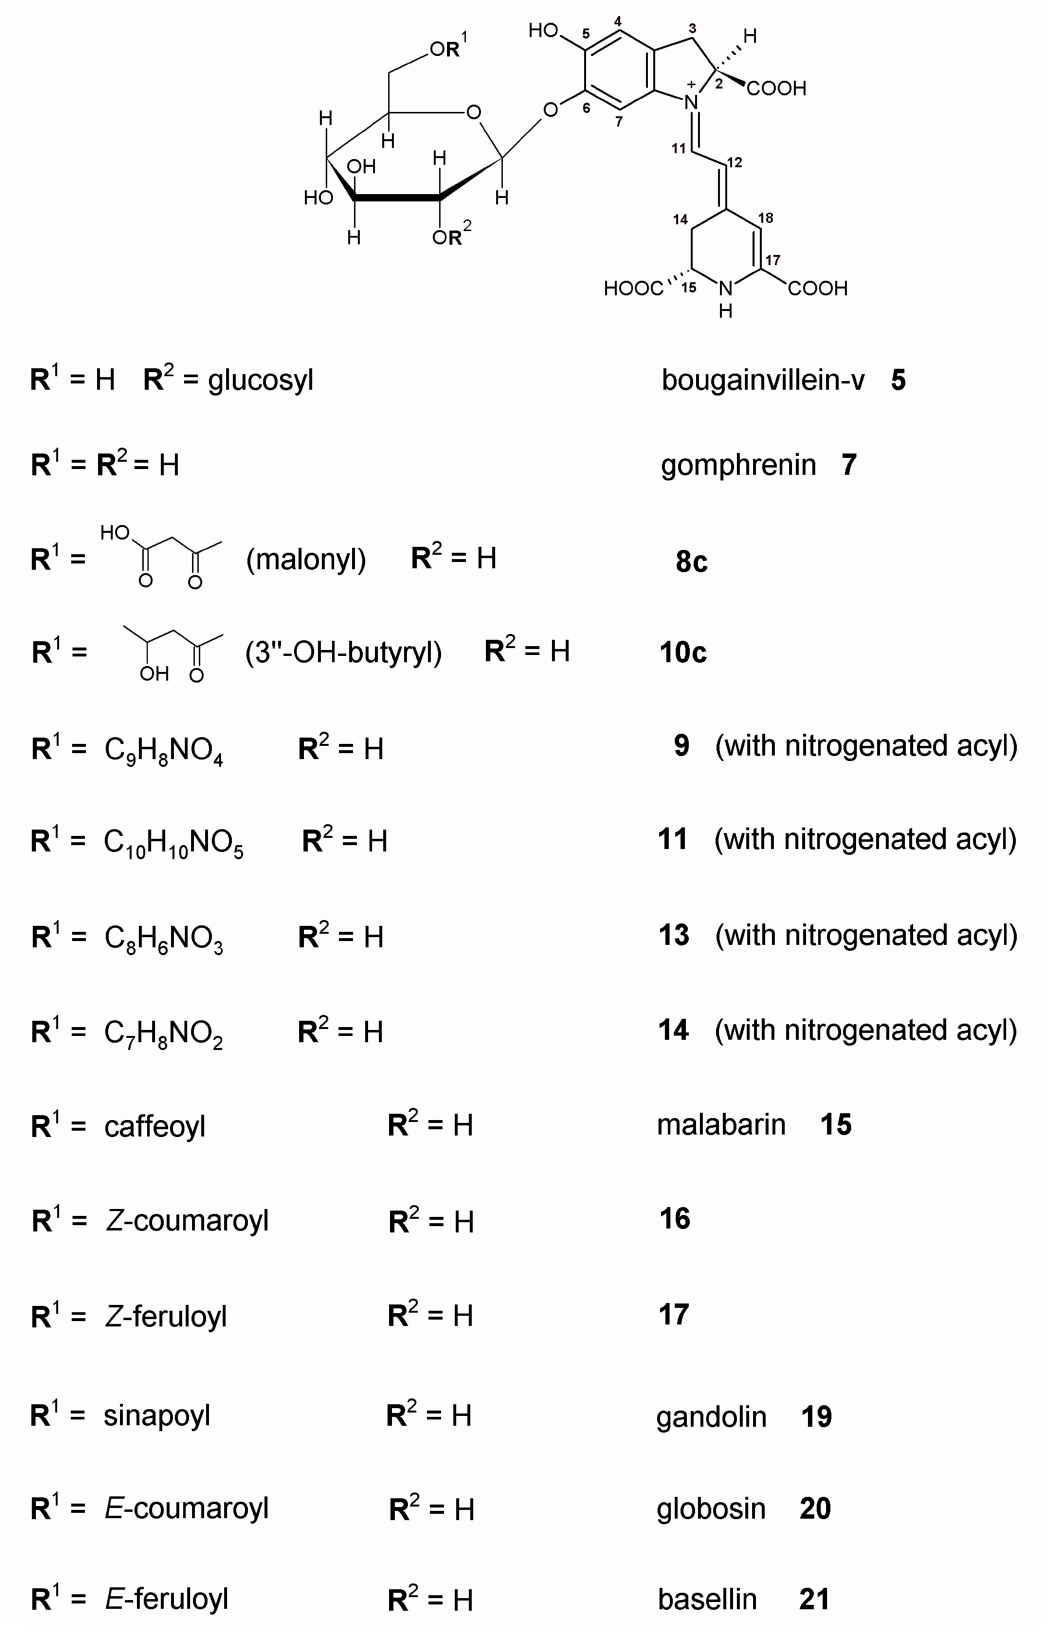
Figure 2. Chemical structures of the detected gomphrenin-based pigments in B. alba and B. alba var. ‘Rubra’ fruit juices with novel acylated